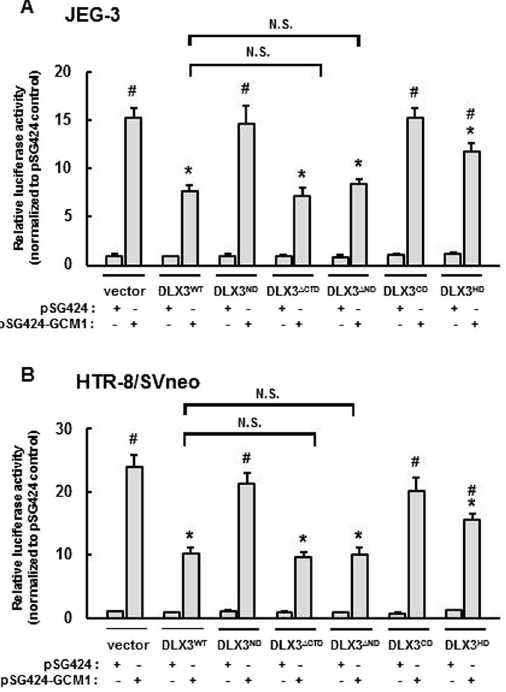
Figure 4. The DLX3 HD and at least one of ND and CD are required for DLX3’s inhibitory effect on the transcription-stimulating activity of GCM1. Mammalian one hybrid assays were carried out in ( A ) JEG-3 cells and ( B ) HTR-8/SVneo cells that were transfected with designated DLX3 structural domain expression plasmid (1 µ g) and pSG424-GCM1 (0.5 µ g; Gal4-GCM1 fusion) together with pGL4.31 (0.5 µ g; luciferase reporter) for 48 h followed by 10 μ M MG-132 treatment for 6 h, and subsequently collected for luciferase assays. Luciferase activity is normalized to protein concentration and the pSG424 (empty Gal4 vector) control. Results are reported as mean ± standard error (SEM) of triplicates from an individual representative experiment. Asterisks denote a statistically significant difference compared with the vector control and the # denotes a statistically significant difference compared with the combination of DLX3 WT and GCM1 by two-way ANOVA followed by the post-hoc Bonferroni test. N.S. = not significantly different.